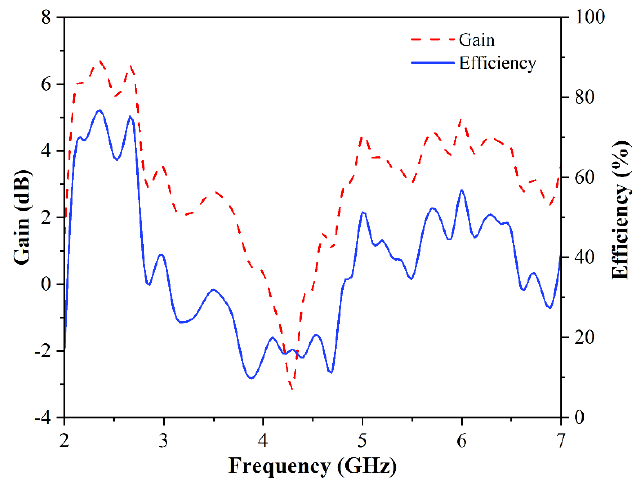
Figure 9. Measured peak gain and radiation efficiency.